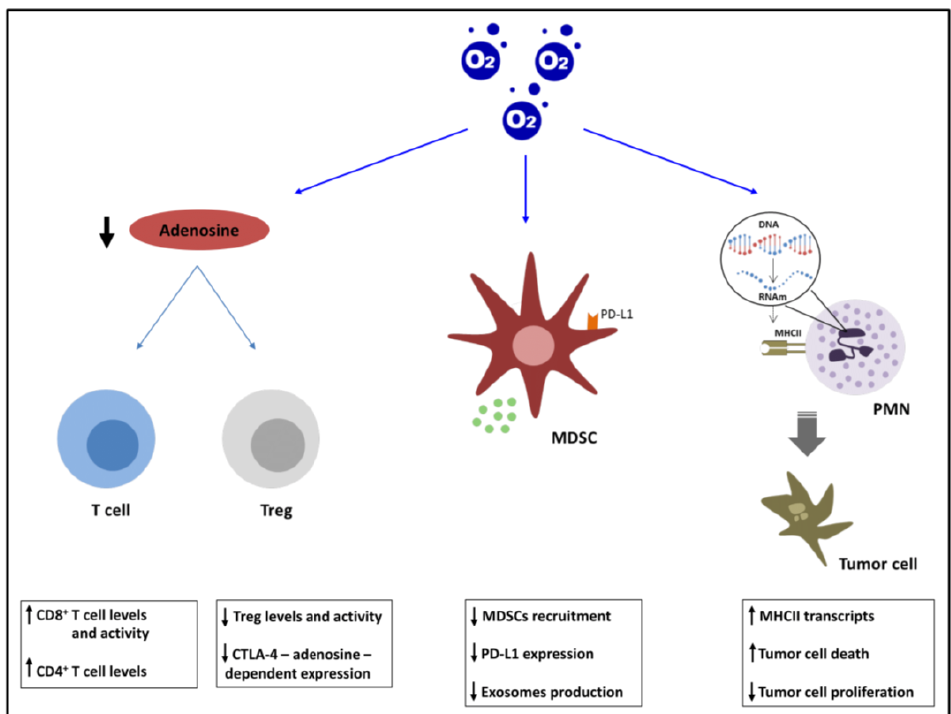
Figure 2. Hyperoxia treatment effect over the immune response. The adenosinergic pathway is altered, presenting a modification in the activity of the effector and regulatory T cells. MDSC recruitment and activity are modified, while PMNs are altered, leading to an immunopermissive TME.